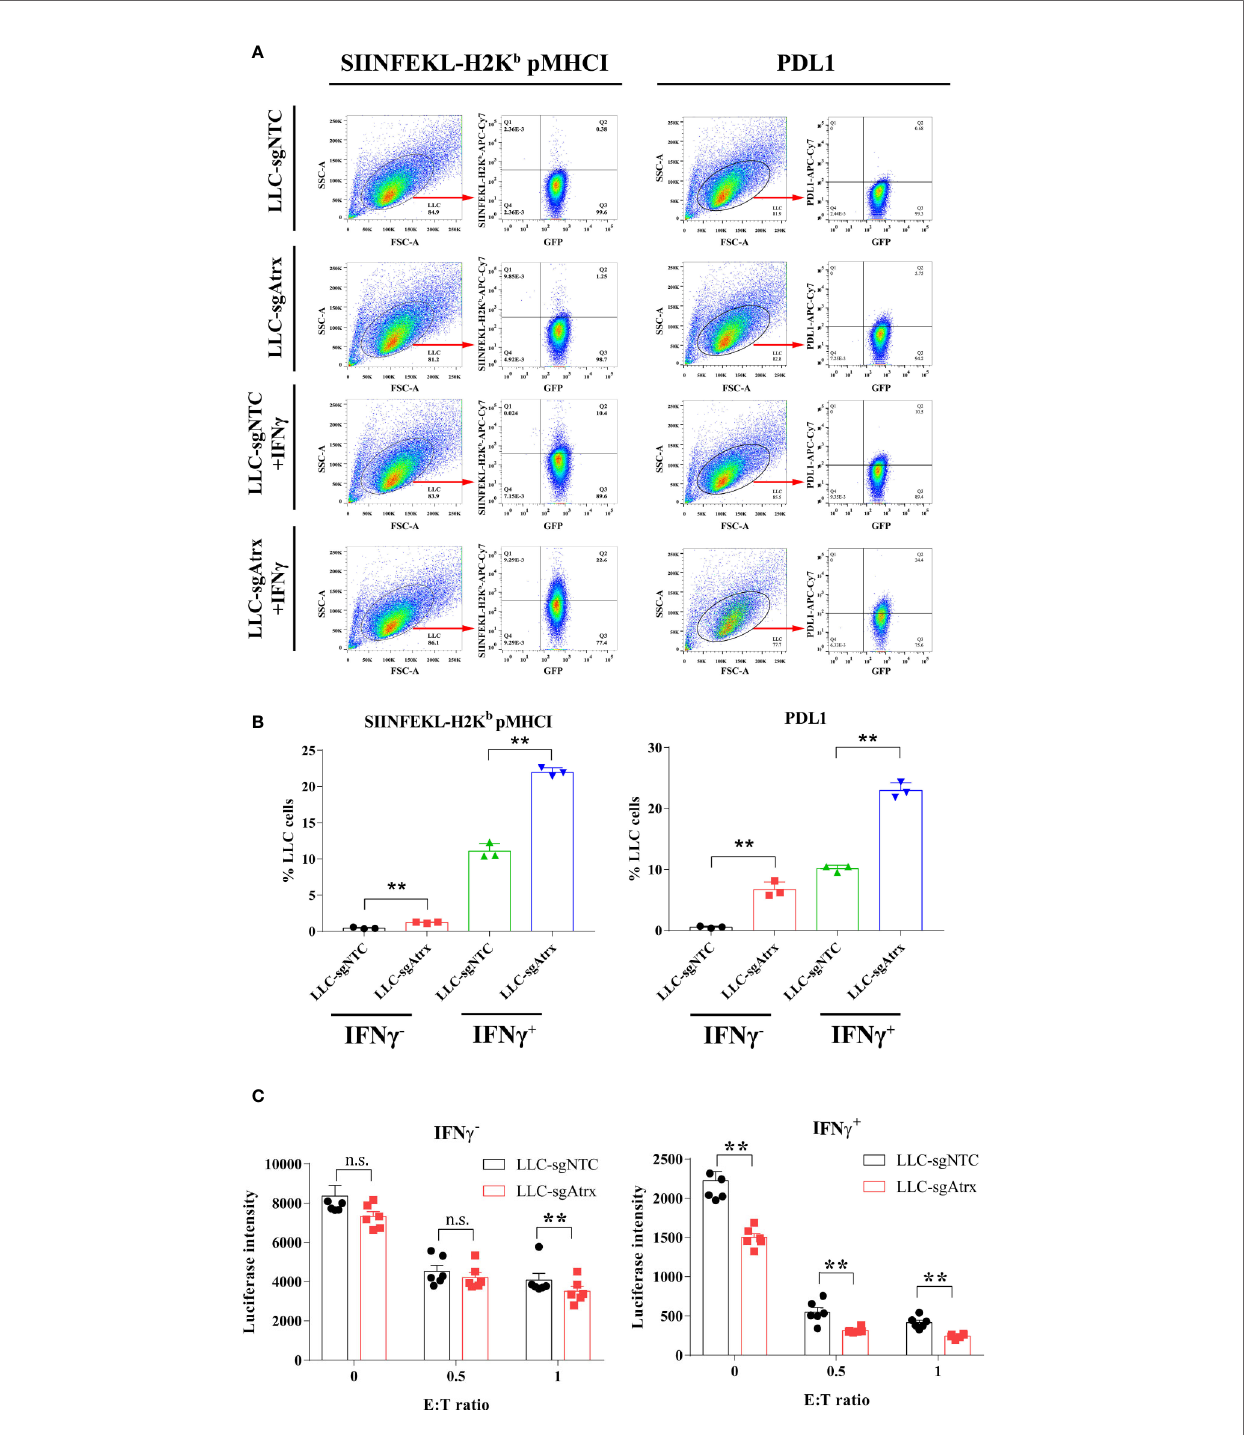
FIGURE 5 | Effect of Atrx de fi ciency on antigen presentation and T cell cytotoxicity. (A) Representative fl ow cytometry analysis of peptide-MHC I and PDL1 surface expression under IFN g treatment in LLC cell lines with and without Atrx de fi ciency. (B) Statistic analysis of the fl ow cytometry data of the expression of peptide-MHC I and PDL1 on the surface of LLC cells. Without IFN g treatment, pMHC I expression was signi fi cantly elevated in LLC-sgAtrx cells, compared with LLC-sgNTC cells (n = 8, P = 0.007). Moreover, after IFN g treatment, pMHC I expression was more signi fi cantly elevated in LLC-sgAtrx cells, compared with LLC-sgNTC cells (n = 8, P = 0.002). (C) T cell cytotoxicity assay by coculturing cognate effective T cells with Atrx mutant or non-mutant LLC cells, treated with 0 or 10 ng/ml IFN g . Without IFN g treatment, the T cells cytotoxicity showed no signi fi cant difference in LLC-sgNTC and LLC-sgAtrx cells at a E:T ratio of 0 (n = 5, P = 0.7012), and 0.5 (n = 6, 0.8529), while the T cell toxicity was signi fi cantly higher in LLC-sgAtrx cells, compared with LLC-sgNTC cells, at an E:T ratio of 1 (n = 6, P = 0.007). Under IFN g treatment, the T cells cytotoxicity was signi fi cant higher in LLC-sgAtrx cells, compared with LLC-sgNTC cells at a E:T ratio of 0 (n = 5, P = 0.0081), 0.5 (n = 6, P = 0.0066), and 1 (n = 6, P = 0.0073). **P<0.01. n.s., not signi fi